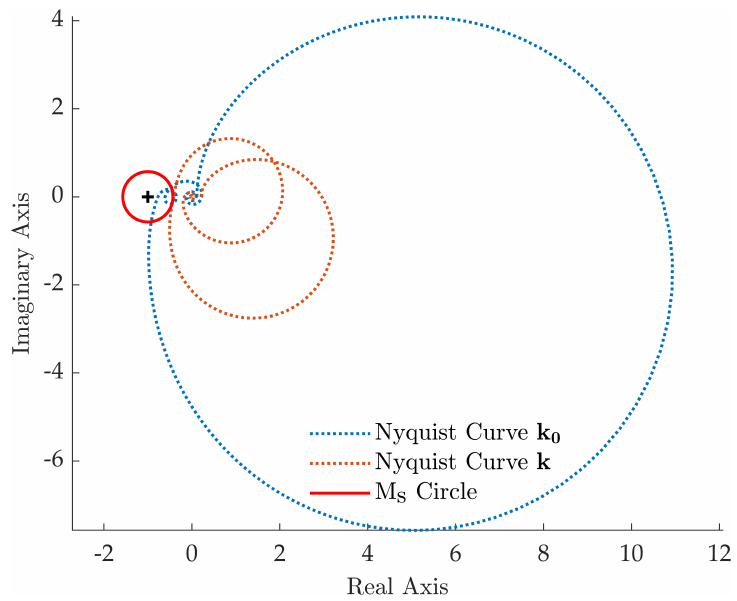
Figure 4. Test case 1: Nyquist curve of L ( j ω )